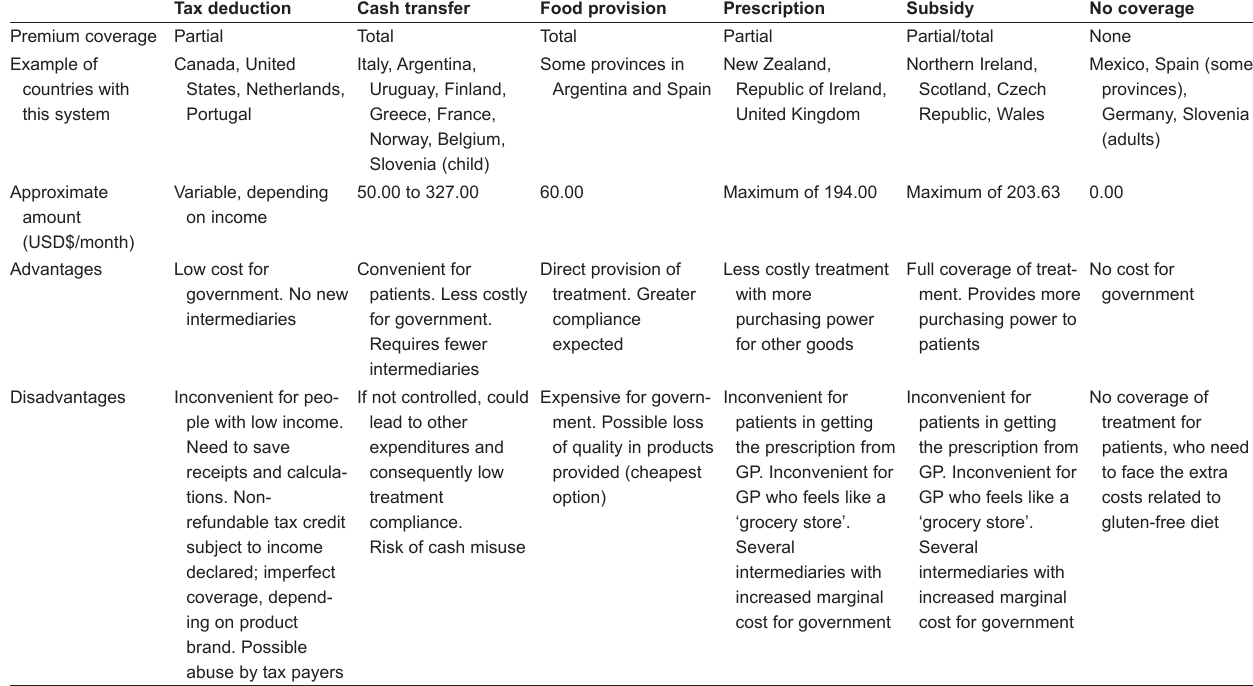
TABLE 4 Differences among available systems for gluten-free product